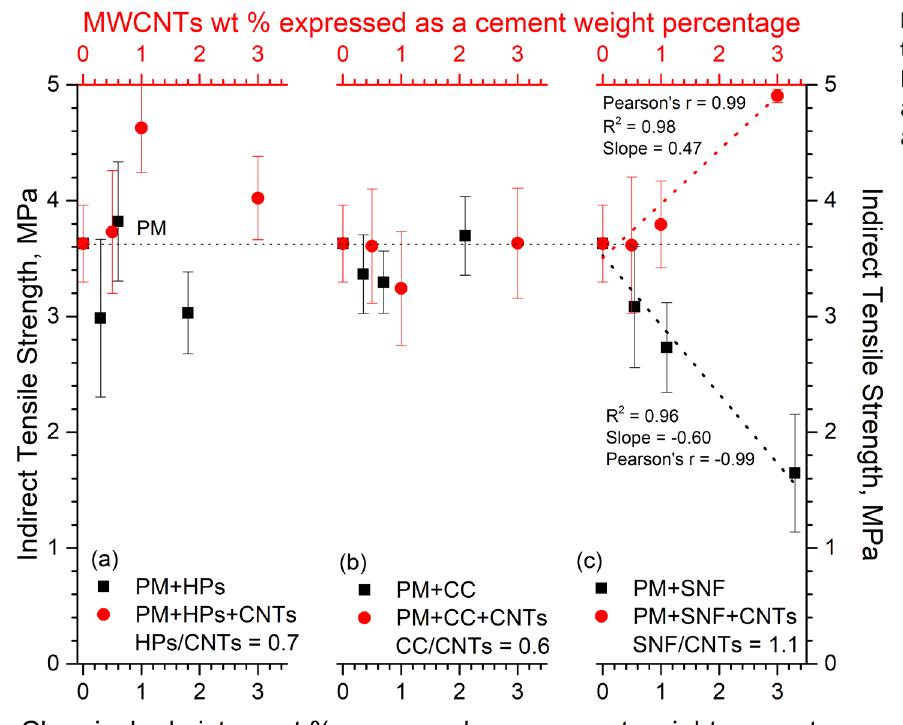
Figure 7. The indirect tensile strength of hardened concrete discs after seven days of curing and